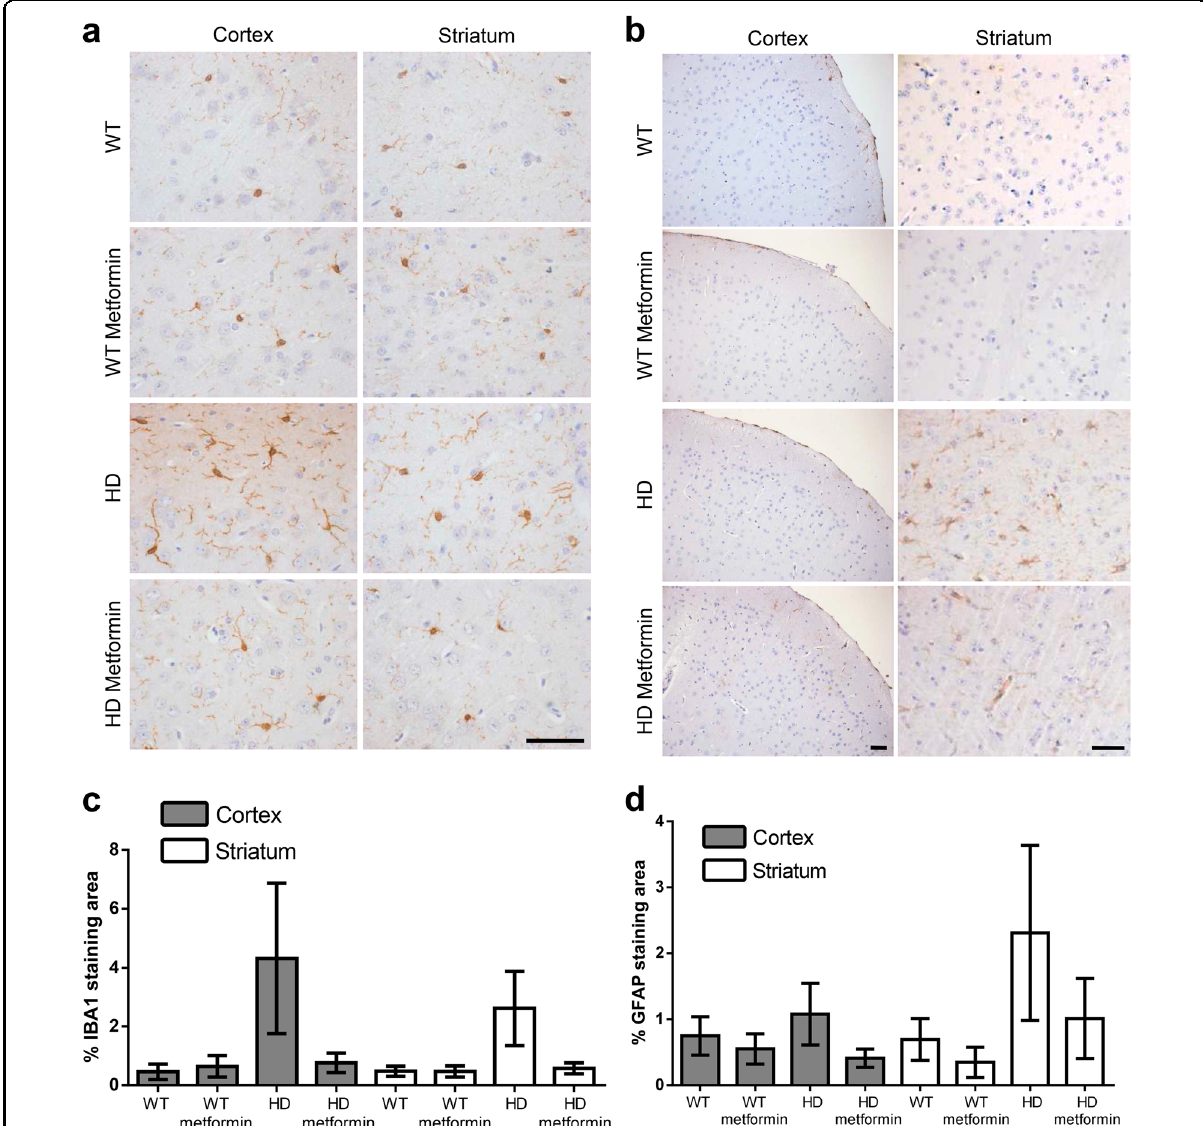
Fig. 7 The in fl ammatory response in the brain tissue of 6-month-old zQ175 mice is reduced after metformin treatment. Immunohistochemical (IHC) staining of the striatum of Huntington disease (HD) and control mice using anti-ionized calcium-binding adaptor molecule 1 (IBA1) ( a ) and anti-glial fi brillary acidic protein (GFAP) ( b ) antibodies. IHC staining of IBA1 and GFAP were signi fi cantly reduced by metformin treatment. Representative images of each condition are shown (bar: 50 µm). c , d The semiquantitative analysis of IHC staining of both biomarkers using the ImageJ software. The number of independent mice and samples from each is as follows: (1) for GFAP, we analyzed 4 nontreated wild type (WT), 3 treated WT, 4 nontreated HD, and 5 treated HD mice, which generated 10 cortex and 8 striatum pictures from untreated wild-type (WT), 6 cortex and 8 striatum pictures from treated wild-type (WT metformin), 4 cortex and 6 striatum pictures from untreated zQ175 (HD), and 7 cortex and 10 striatum pictures from HD treated (HD metformin) mice. The analyzed area in each picture was 361,920 μ m 2 ; (2) for IBA1, we analyzed 4 mice from each group (nontreated and treated WT mice and nontreated and treated HD mice), which generated 4 cortex and 10 striatum pictures from untreated wild-type (WT), 7 cortex and 5 striatum pictures from treated wild-type (WT metformin), 6 cortex and 9 striatum pictures from untreated zQ175 (HD) and 11 cortex and 13 striatum pictures from HD treated (HD metformin) mice. The analyzed area in each picture was 36,580 μ m 2 . c Analysis of these data indicates that HD mice expressed higher levels of IBA1 than WT mice in both the cortex and striatum ( p < 0.001 in both cases) and that metformin reduced the levels of IBA1 to those of WT mice ( p = 0.932). d HD mice expressed higher levels of GFAP than WT mice ( p < 0.001). Treatment with metformin signi fi cantly reduced GFAP levels in HD mice to levels similar to those of WT mice ( p = 0.33). Values are the mean, and bars indicate the con fi dence interval (95%